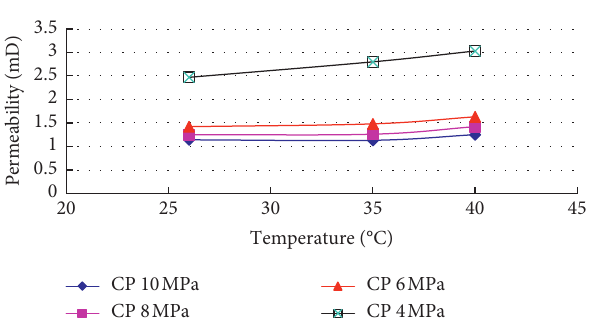
Figure 12: At 40 ° C.